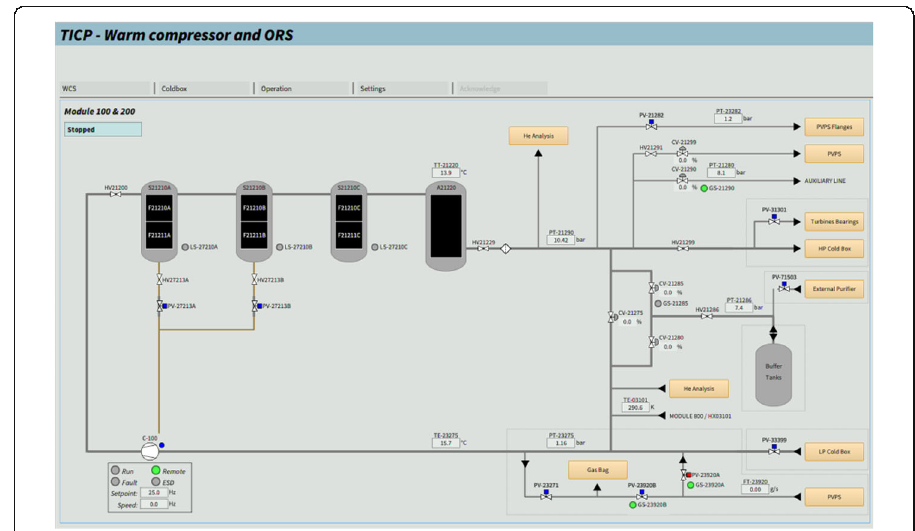
Fig. 7 Revised operator screen in TICP